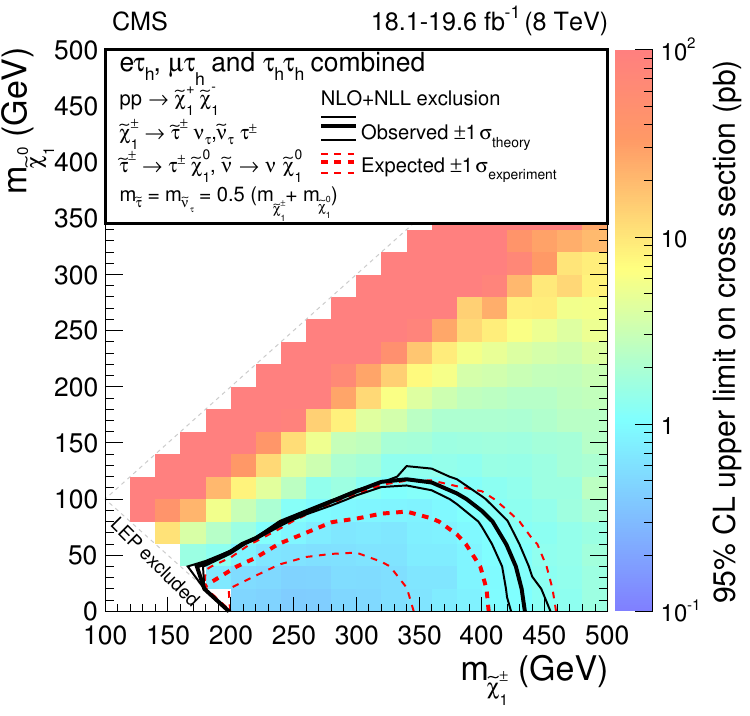
Figure 5 . Expected and observed exclusion regions in terms of simpli(cid:12)ed models of chargino pair production with the total data set of 2012. The triangle in the bottom-left corner corresponds to e (cid:28) masses below 96 GeV, which has been excluded by the LEP experiments [68]. The expected limits and the contours corresponding to (cid:6) 1 standard deviation from experimental uncertainties are shown as red lines. The observed limits are shown with a black solid line, while the (cid:6) 1 standard deviation based on the signal cross section uncertainties are shown with narrower black